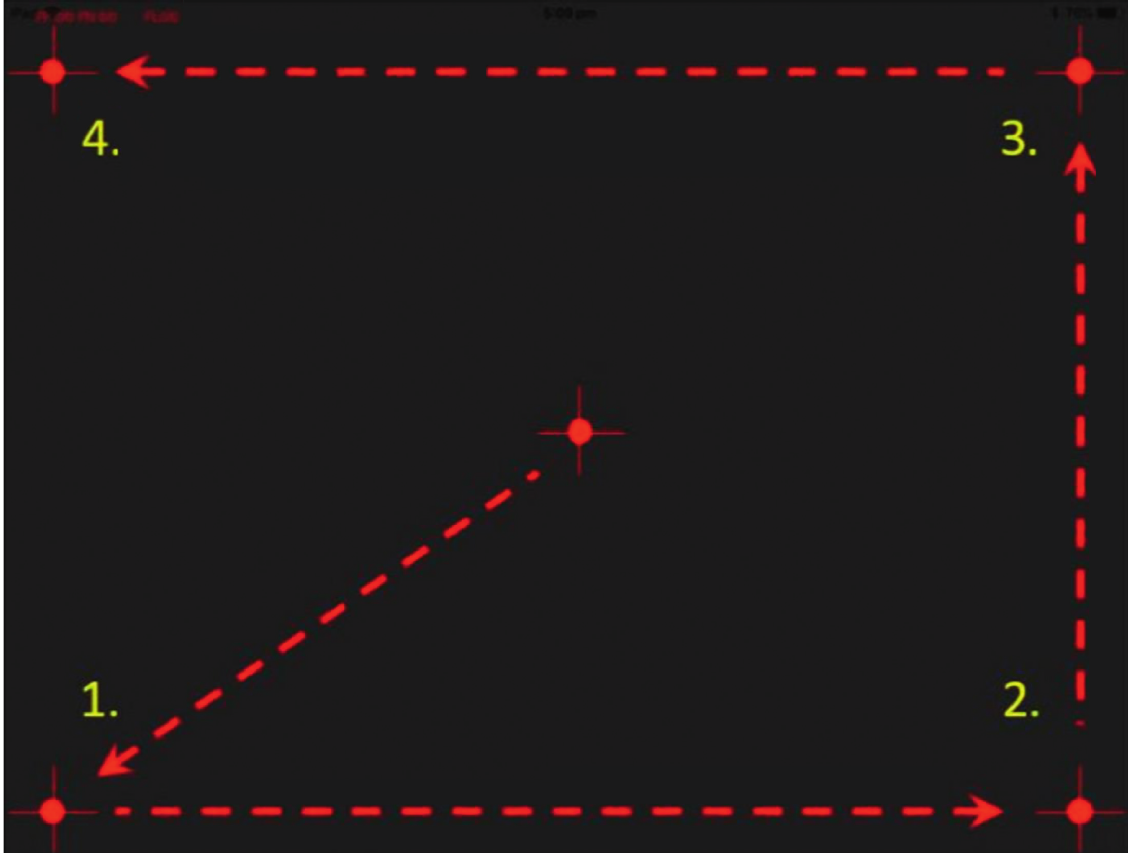
Figure 2: Fixation changes during Melbourne Rapid Fields (MRF) testing (for 9.7 ″ , 10.5 ″ , and 11 ″